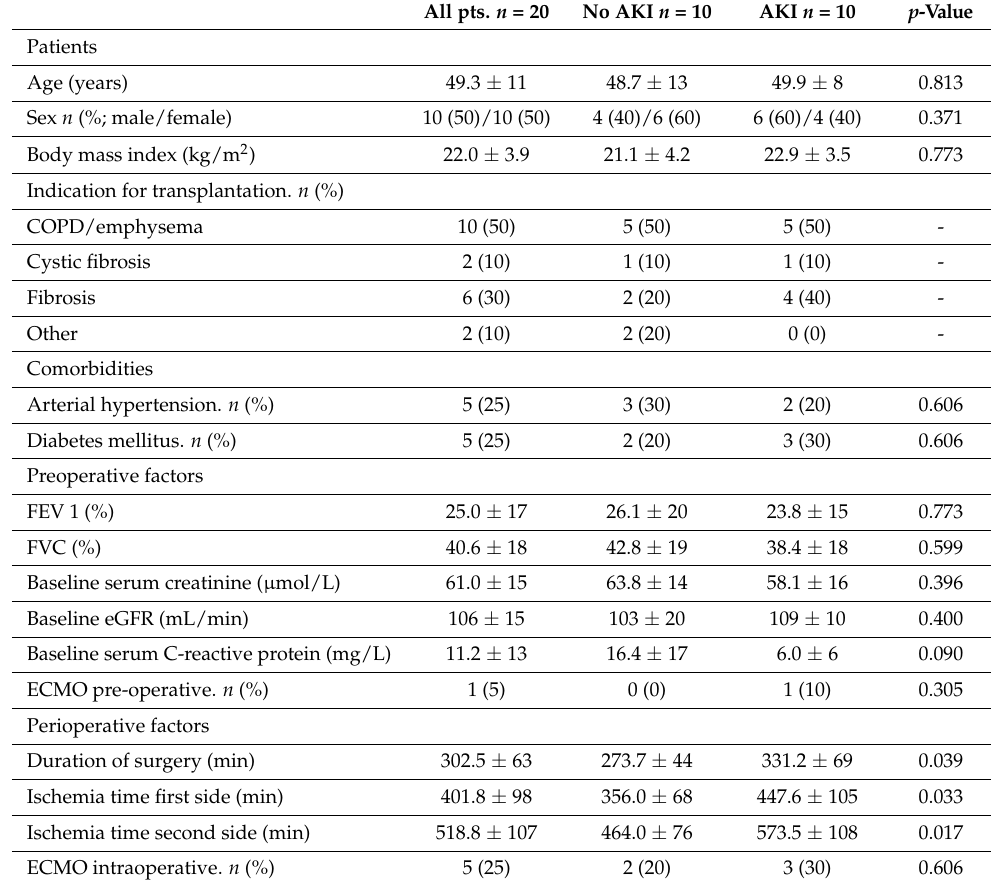
Table 1. Pre-, peri-, and postoperative data of LuTx patients (mean ± standard deviation). All pts. n = 20 No AKI n = 10 AKI n =